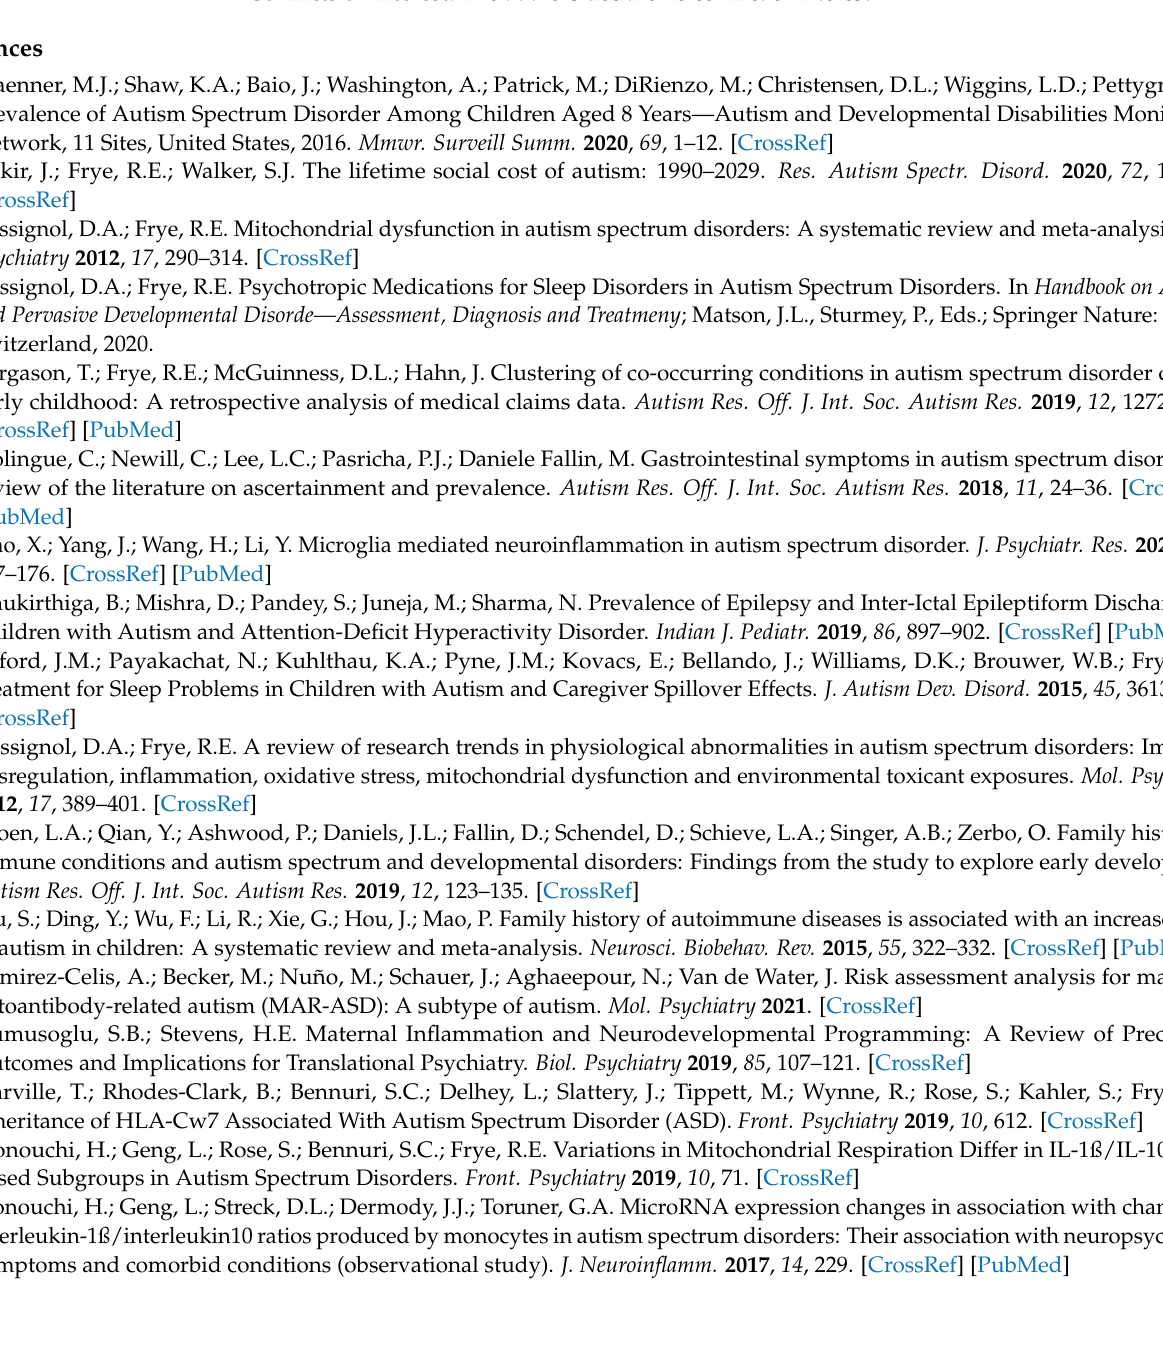
Table S2: Number of Participants for Meta-analysis of studies on immunoglobulin G Concentration in Autism Spectrum